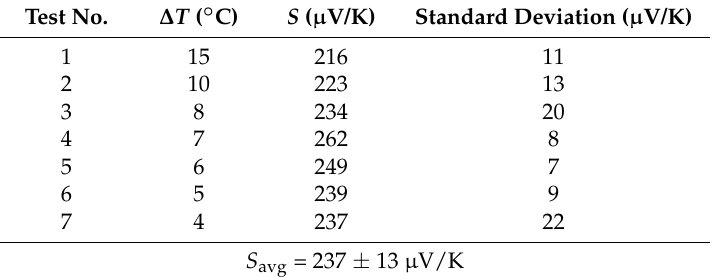
Table 3. Seebeck coefficient of the Bi-Te-Ni-Cu-Au nanostructure.